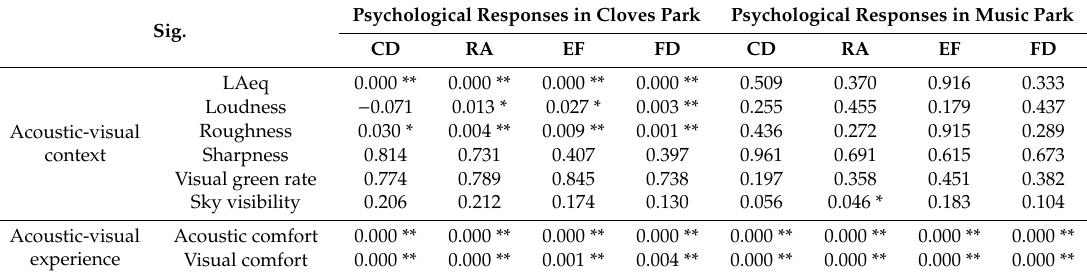
Table 1. The Pearson correlation results between acoustic and visual environments and psychological responses in two parks. Sig.